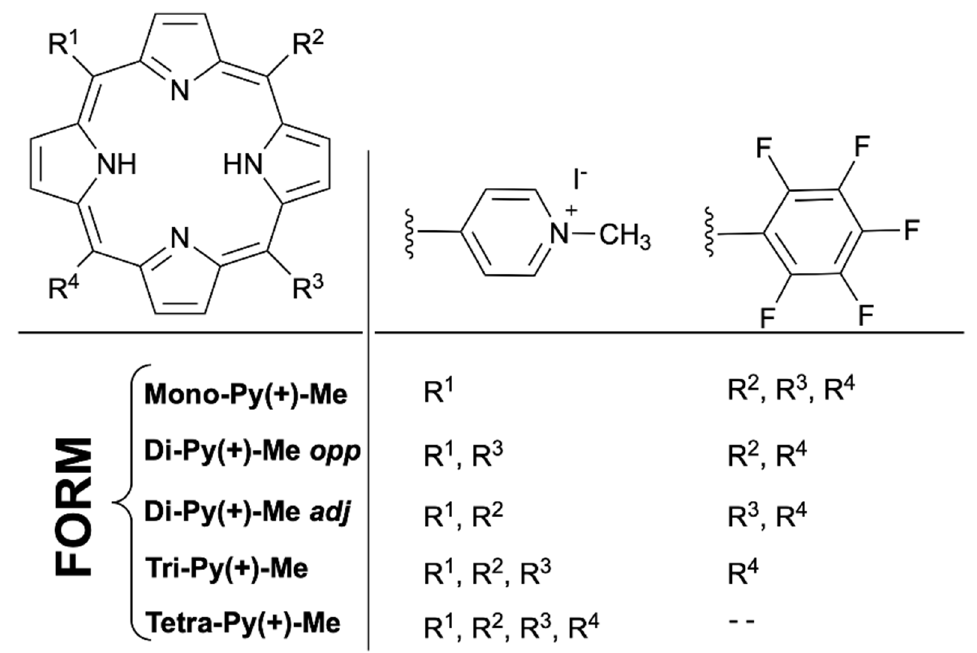
Figure 6. The chemical structure and respective acronyms of the porphyrin derivatives composing the non-separated mixture of meso -tetraarylporphyrins, named as Form in the present work. mixture of meso -tetraarylporphyrins, named as Form in the present